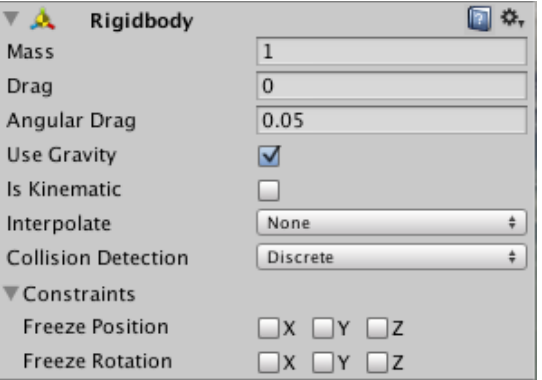
Figure 18. Tabs of the “ Advanced Ship Controller ” component.